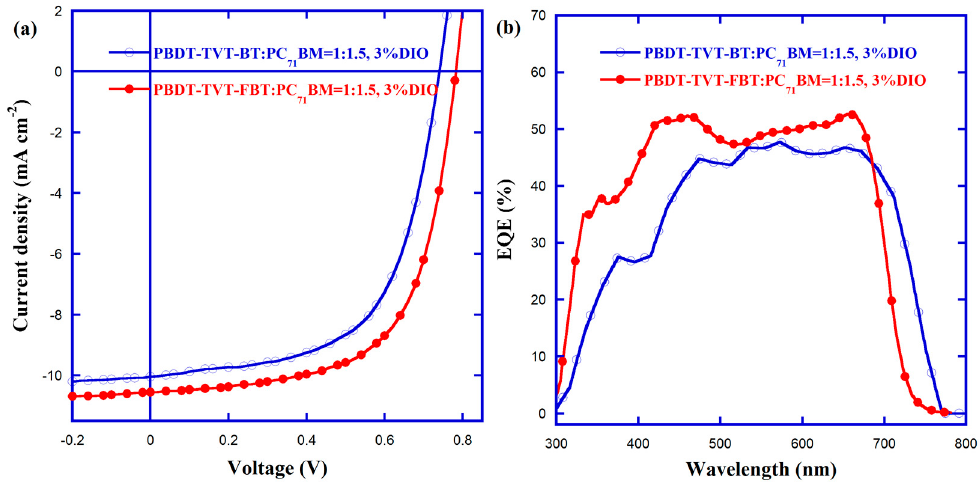
Figure 7. The optimal J – V curves ( a ) and EQE spectra ( b ) for PSCs based on PBDT-TVT-BT and PBDT-TVT-FBT. Table 3. The optimized photovoltaic parameters of PSCs based on PBDT-TVT-BT and PBDT-TVT-